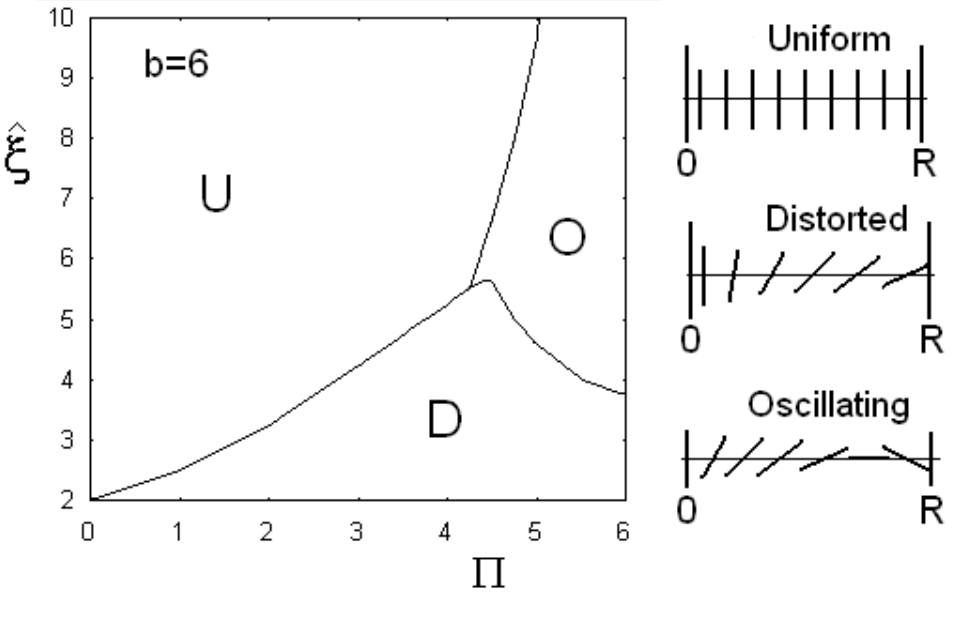
Figure 10. Phase diagram of the cylindrical confinement, when the anchoring parameter b is fixed and equal to 6. The three regions are denoted by U for the uniform alignment of director parallel to the cylinder axis, D when the director has a deformed configuration, and O if director is oscillating and cosine becomes negative